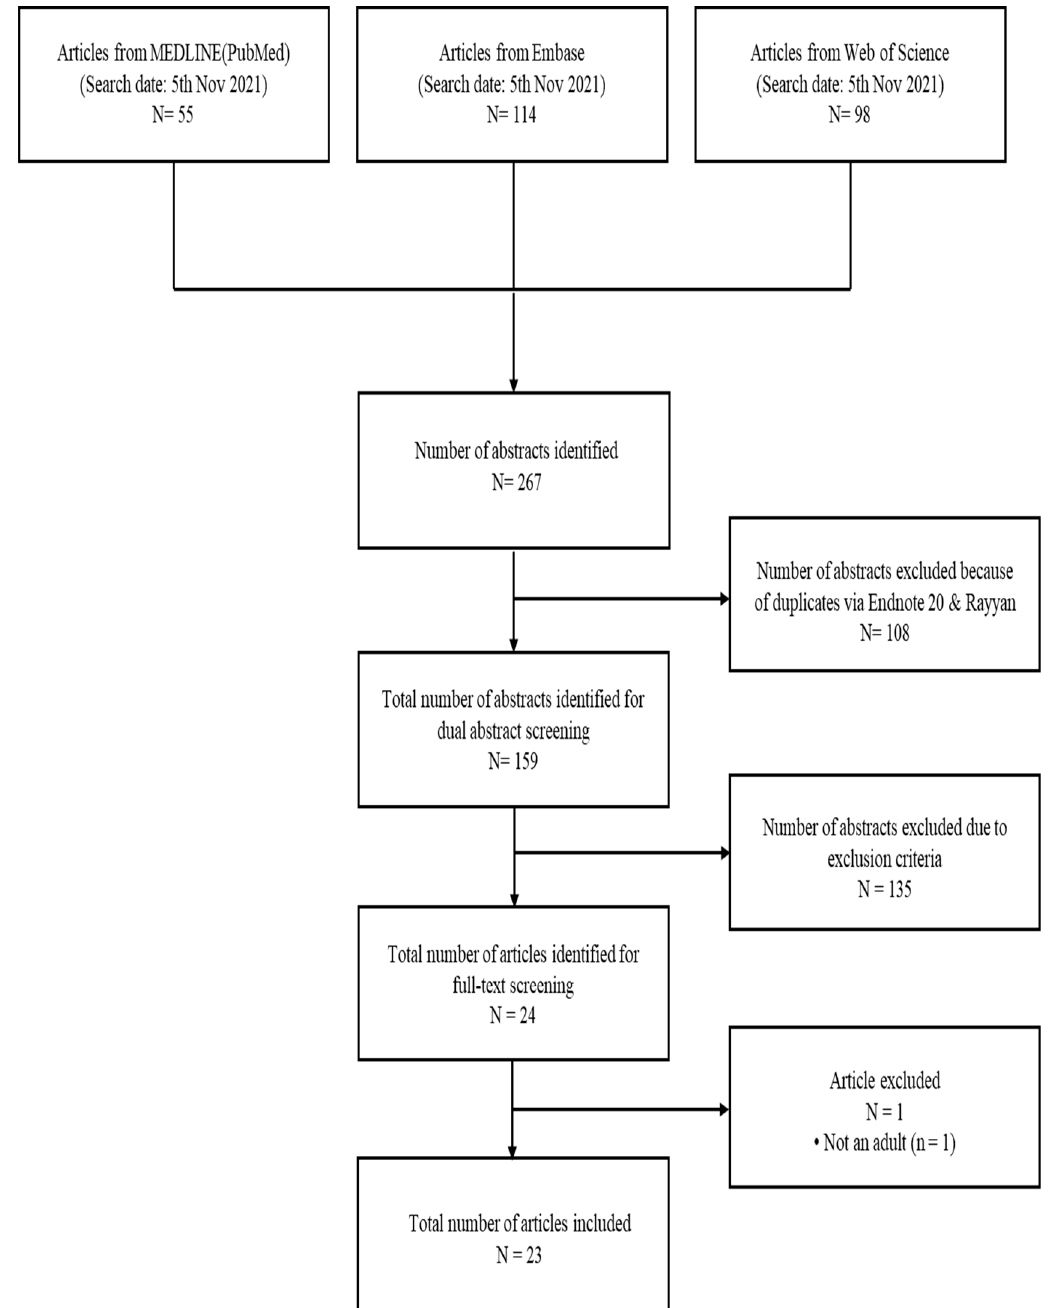
Figure 1. Literature search and study selection process.